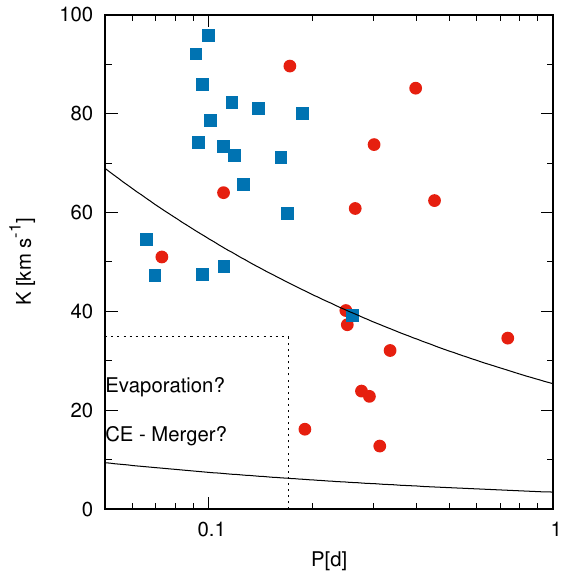
Figure 2. This figure is an updated version of Figure 4 from Schaf- fenroth et al. (2014a). It shows the RV semiamplitudes of all known sdB binaries with reflection effects and spectroscopic solutions plotted against their orbital periods. Blue squares mark eclips- ing sdB binaries of HW Vir type where the companion mass is well constrained. Red circles mark systems without eclipses, where only lower limits can be derived for the companion masses. The lines mark the regions to the right where the minimum compan- ion masses derived from the binary mass function (assuming 0.47 M for the sdBs) exceed 0.01 M (lower curve) and 0.08 M (upper ⊙ ⊙ ⊙